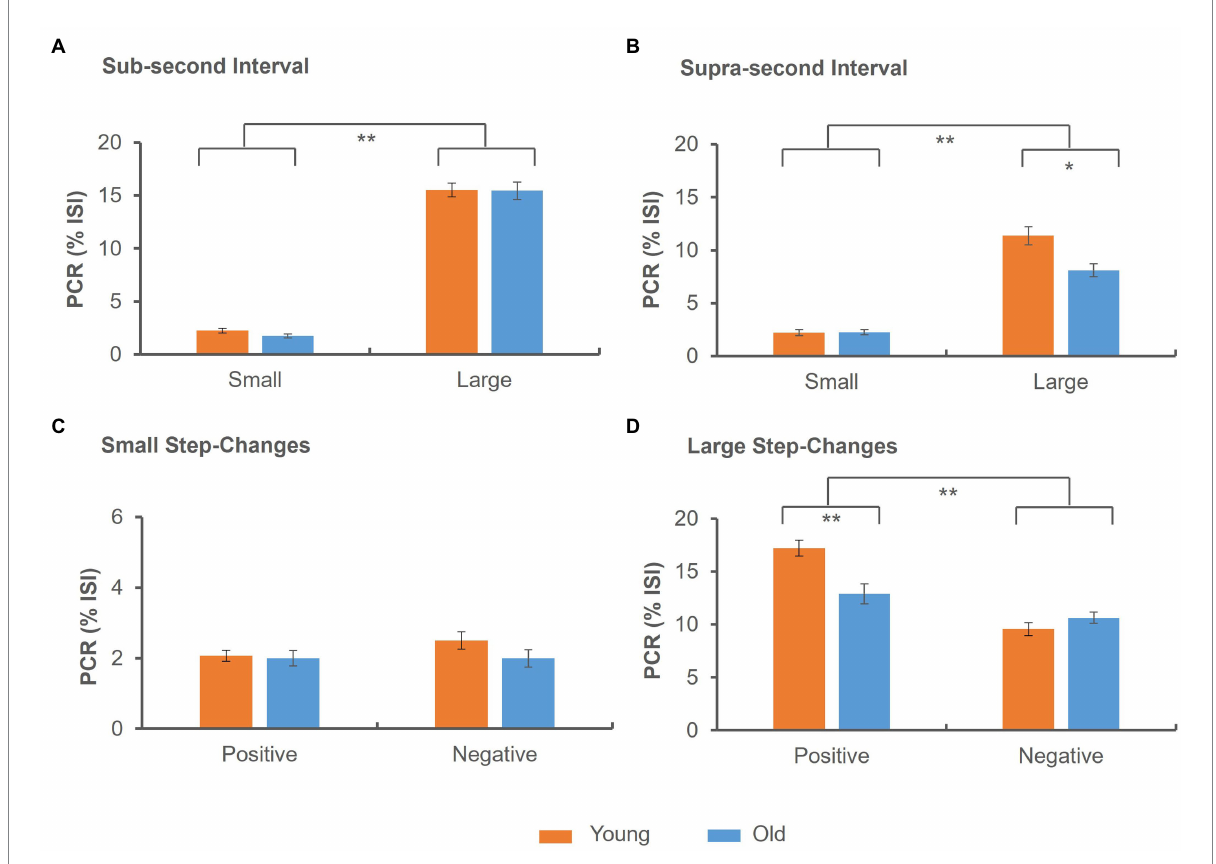
FIGURE 4 Phase correction response (PCR) in percent of the base SOA. (A) In trials with sub-second intervals no significant group differences emerged. (B) In trials with supra-second intervals the PCR was significantly smaller in the old as compared to the young group. (C) Small step-changes were not associated with significant group differences, (D) while large positive step-changes yielded significantly smaller PCR in the old as compared to the young group. Error bars indicate the standard error of the mean * p ≤ 0.05; ** p ≤